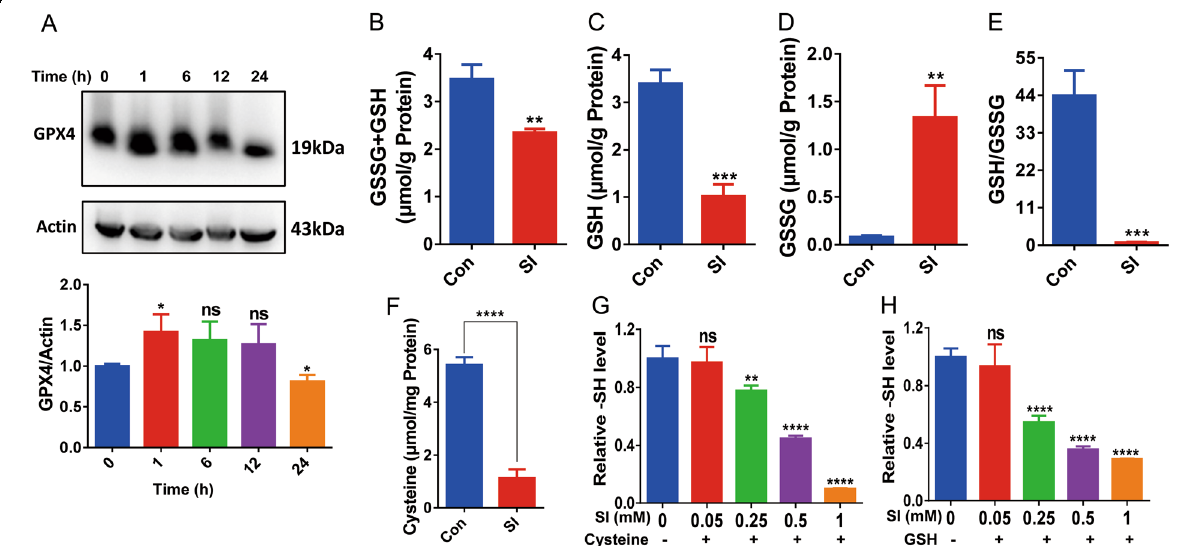
Fig. 5 SI reacts directly with cysteine and GSH in ARPE-19 cells. A Upper panel: Western blotting detection of GPX4 expression in cells treated with 10 mM NaIO 3 for the indicated time. Lower panel: the quanti fi cations of three repeats from the upper panel. B – E The glutathione levels in ARPE- 19 cells treated for 24 h with or without 10 mM NaIO 3 . B Total glutathione levels; C reductive glutathione levels; D oxidative glutathione levels; and E ratios of reductive to oxidative glutathione levels ( n = 3). F The concentration of cysteine in ARPE-19 cells with or without 10 mM NaIO 3 treatment for 24 h ( n = 3). G , H In vitro reaction between SI and cysteine or GSH. 10 mM cysteine ( G ) or 10 mM GSH ( H ) was incubated with NaIO 3 at indicated concentrations for 10 min at 37 °C. The residual sulfhydryl was assayed using a cysteine assay kit ( n =